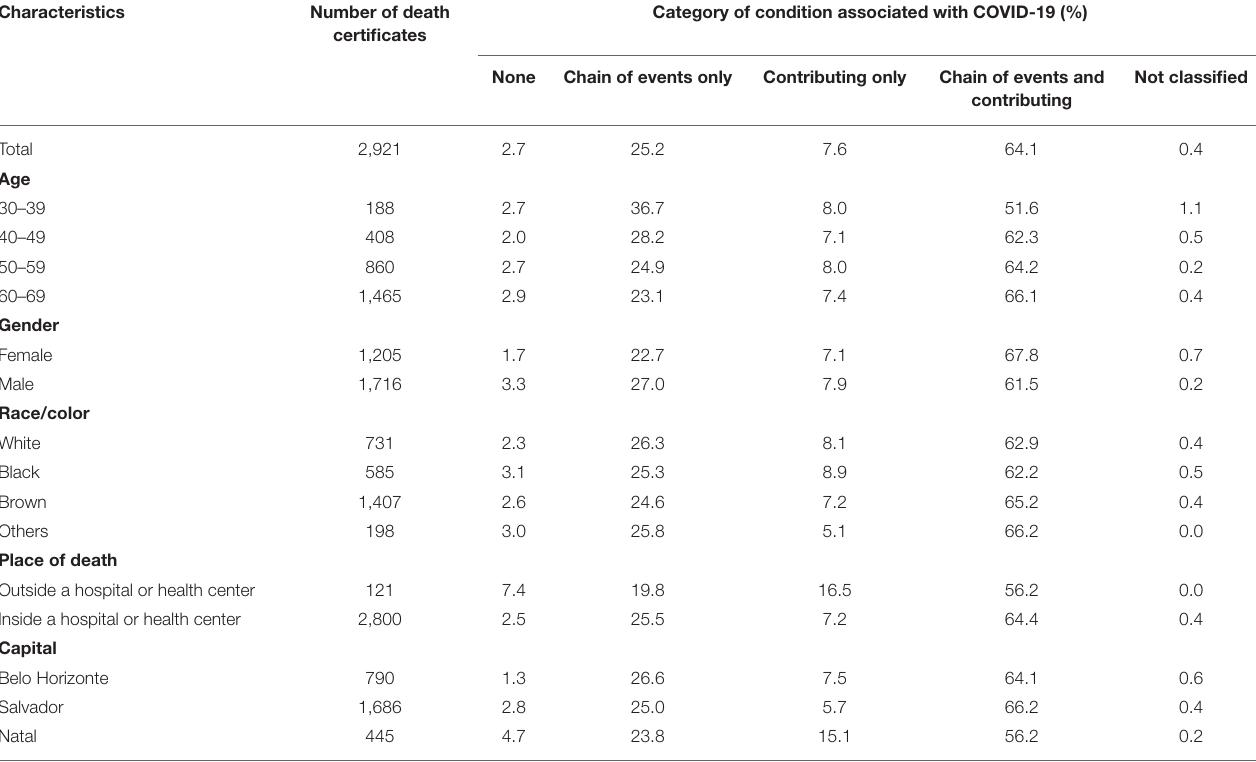
TABLE 3 | Distribution of conditions associated with COVID-19 by category according to characteristics of the deceased and local of death, at ages 30–69 years, in three Brazilian capitals, 2020. Characteristics Number of death Category of condition associated with COVID-19 (%) certificates None Chain of events only Contributing only Chain of events and Not contributing